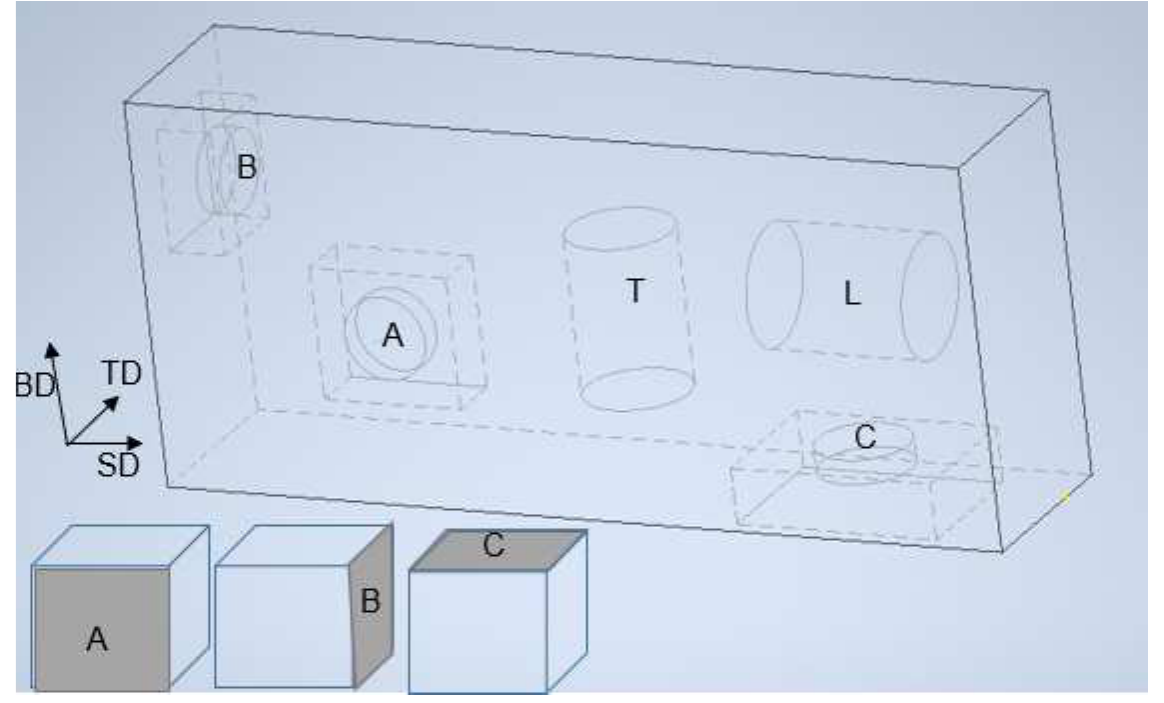
Figure 2. Direction of testing, where (L) and (T) stand for the conventional tensile tests; (A), (B) and (C) for SPT tests and microstructure analysis; and BD—building direction, SD—scanning direction and TD—thickness direction.